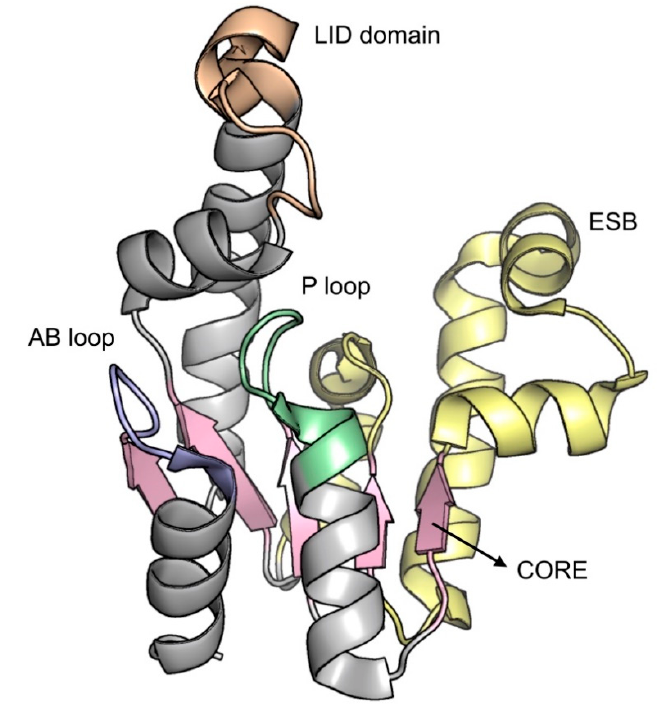
Figure 11. Overall Mt SK structure. The image was generated on